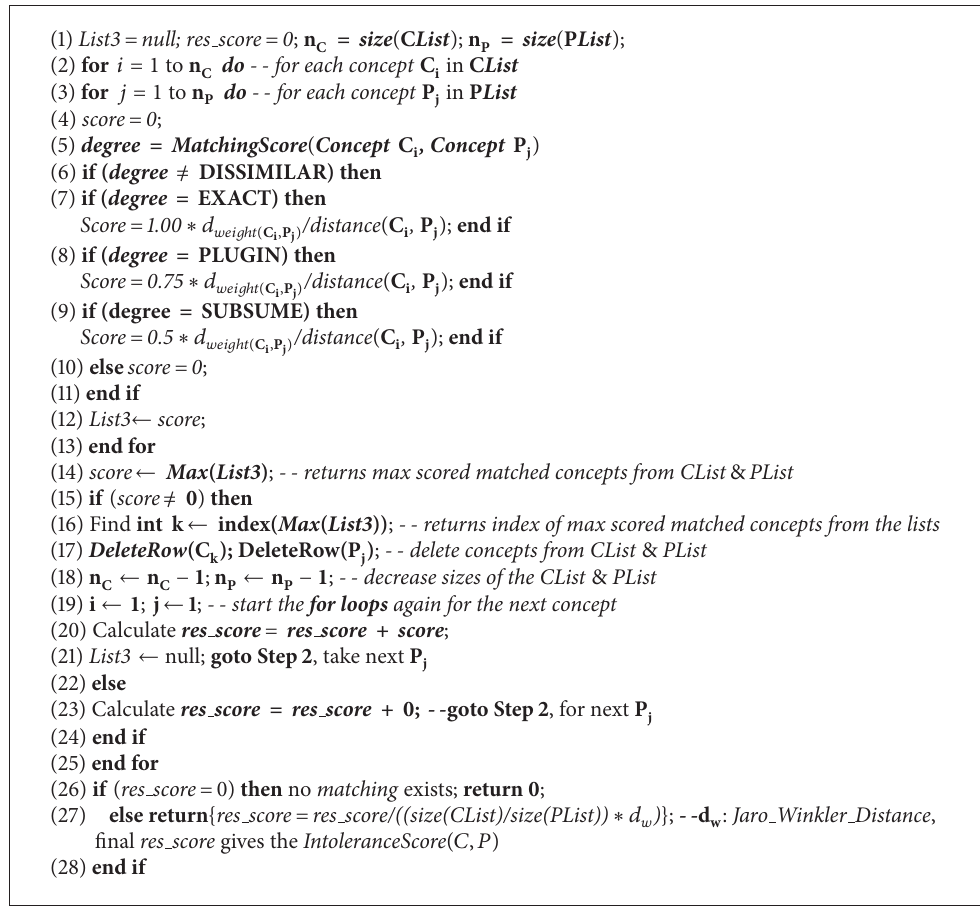
Algorithm 2: getIntoleranceScore (CList, PList) .